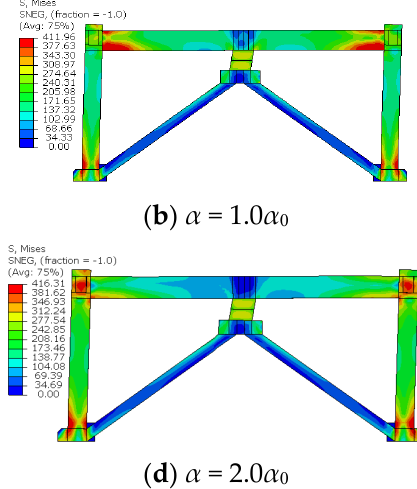
Figure 13. Stress nephograms of a steel frame for different α values.